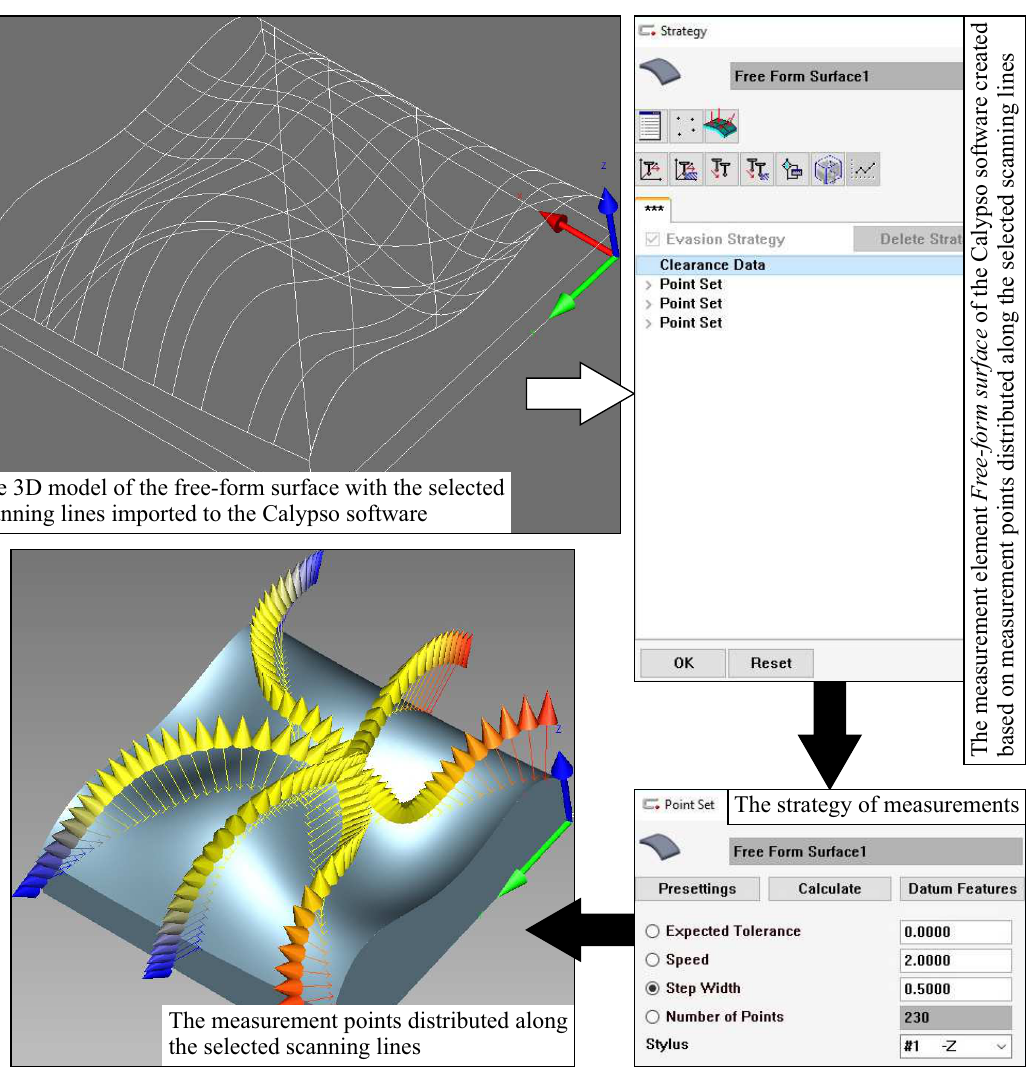
Figure 17. The most important stages of implementation of the created method in the commercial measurement